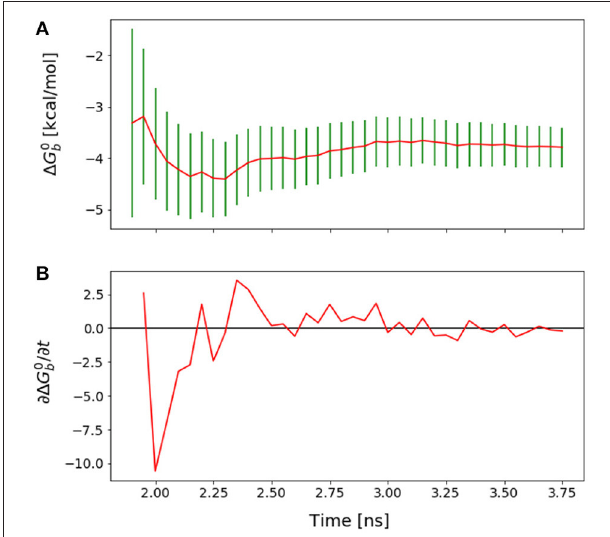
FIGURE 5 | (A) Forward cumulative convergence plot for Mutant 4 after the initial bias has been removed. (B) Plot of the fluctuations of 1 G 0 B that shows a steady decay toward